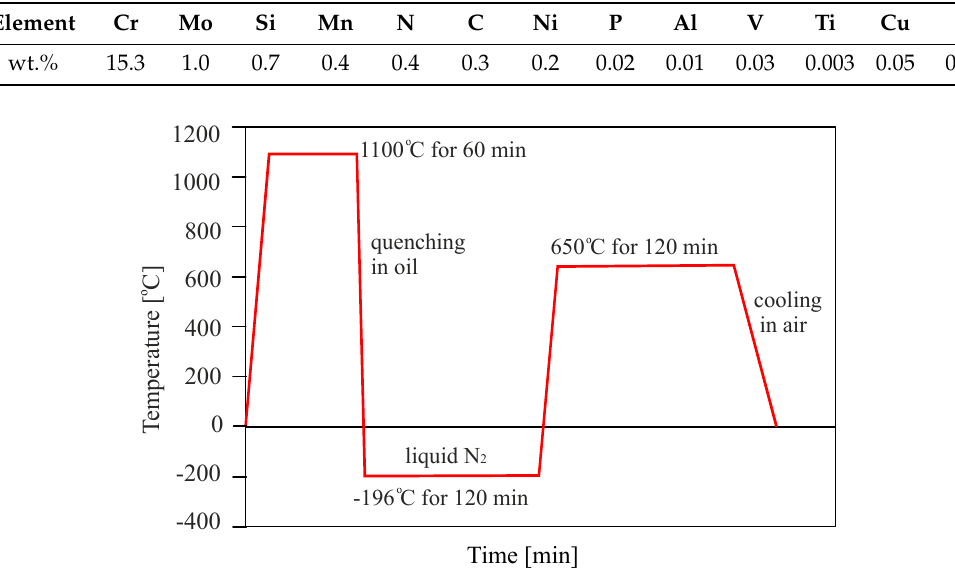
Figure 1. Heat treatment procedure.